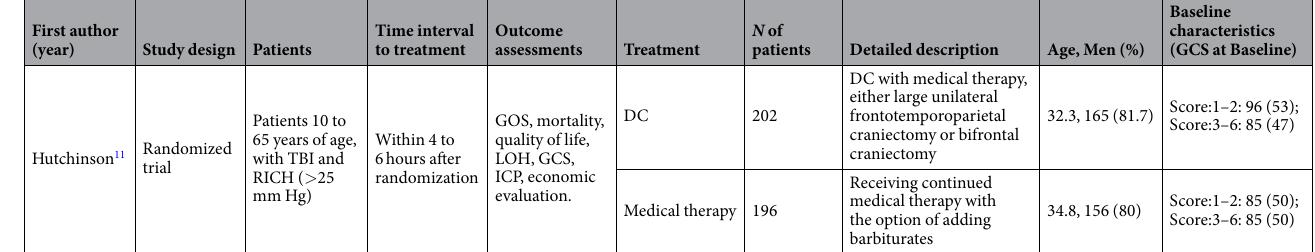
Table 1. Characteristics of included studies. CBF, Cerebral Blood Flow; CPP, Cerebral Perfusion Pressure; CT, Computed Tomography; DC, Decompressive Craniectomy; ICH, Intracranial Hypertension; ICP, Intracranial Pressure; ICU: intensive care unit; IQR, Interquartile Range; GCS, Glasgow Coma Scale; GOS, Glasgow Outcome Scale; LOH, Length of Hospitalization; LO-ICU, Length of ICU Stay; NA, Not Available; RICH, Refractory Intracranial Hypertension; TBI, Traumatic Brain